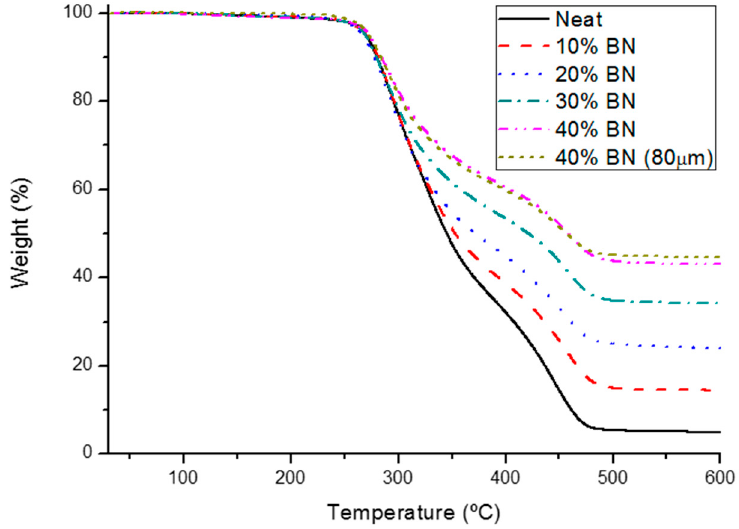
Figure 4. Degradation curves of thermosets obtained by TGA under inert atmosphere at 10 K/min.